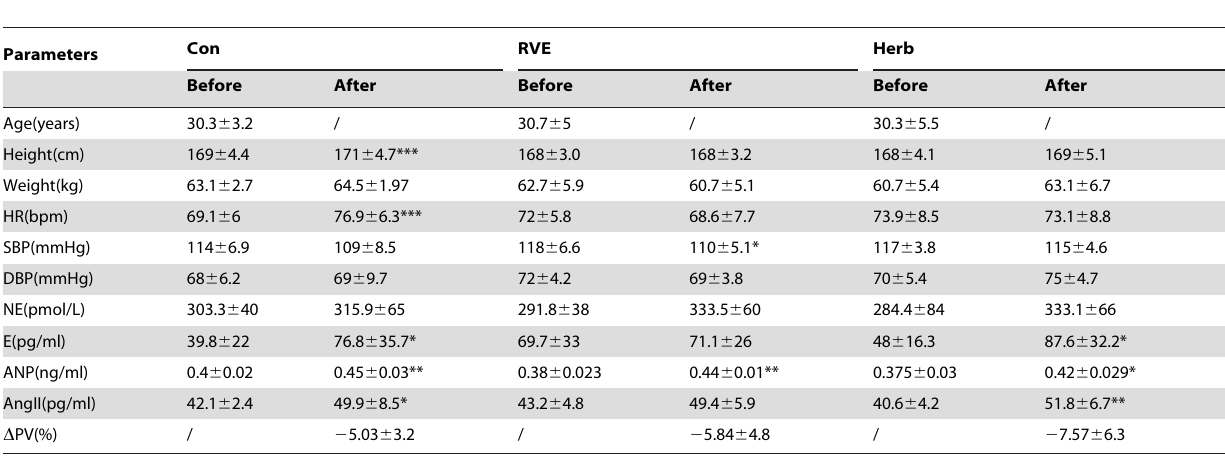
Table 1. Subject characteristics, blood biochemical parameters and changes in plasma volume before and after 60 days of HDBR without(Con) or with countermeasures (RVE and